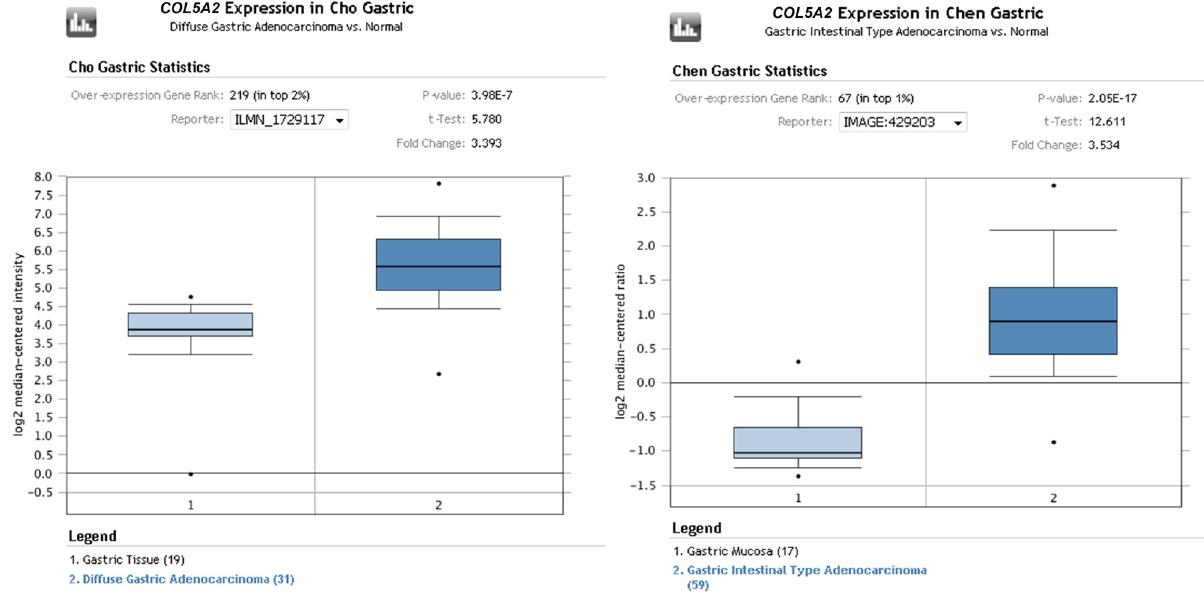
Figure A1: Oncomine analysis revealed that the mRNA expression of COL5A2 was up - regulated in